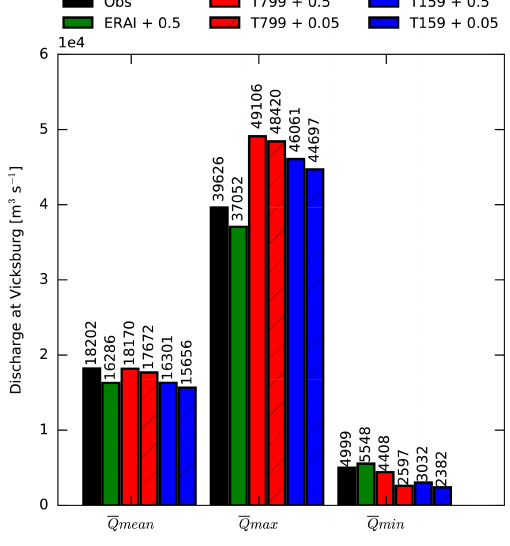
Figure 14. Q mean , Q max , and Q min in m 3 s − 1 at Vicksburg for the observations and the different combinations of